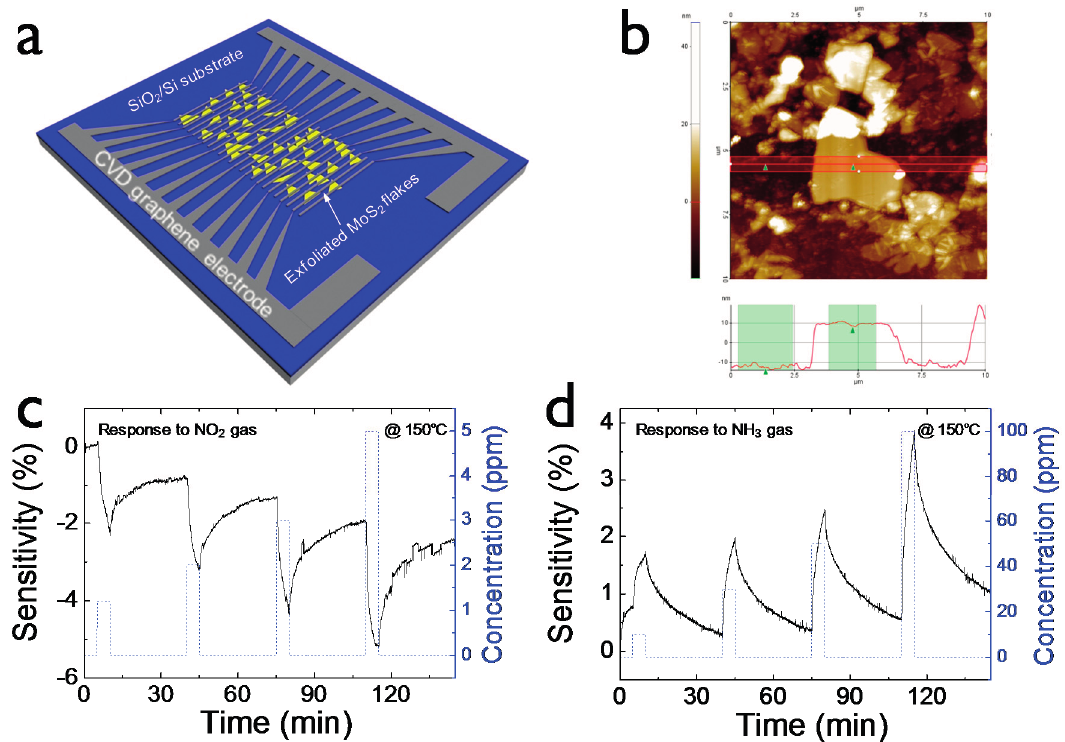
Figure 1. ( a ) Schematic image of the gas-sensing device consisting of mechanically exfoliated MoS 2 flake channels and CVD-synthesized graphene electrodes; ( b ) AFM morphology of MoS 2 flake connecting patterned graphene lines; Bottom indicates a height profile of MoS2. Transient response to ( c ) NO 2 concentration of 1.2 to 5 ppm and ( d ) NH 3 concentration of 10 to 100 ppm, respectively. All gas-sensing tests were carried out at an operating temperature of 150